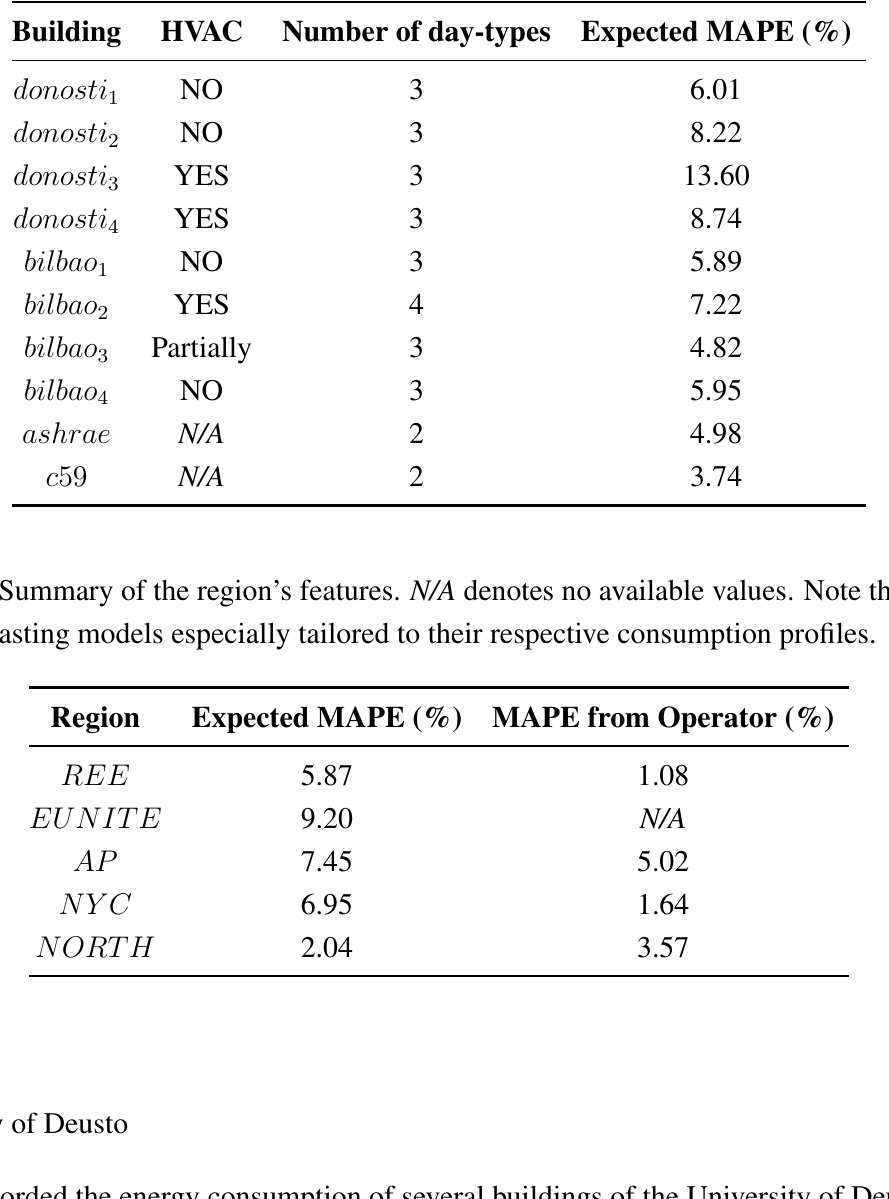
Table 1. Summary of the buildings’ features. N/A denotes unknown values.